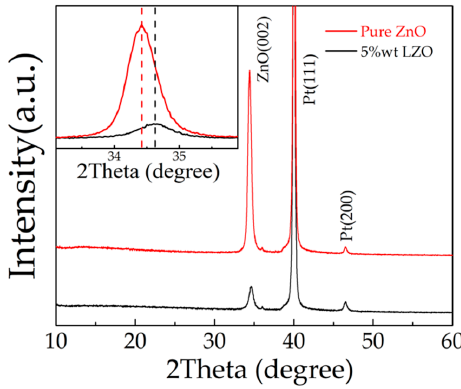
Figure 6. XRD spectra of the LZO thin film (inset shows (002) peaks of pure ZnO and 5 wt % LZO).